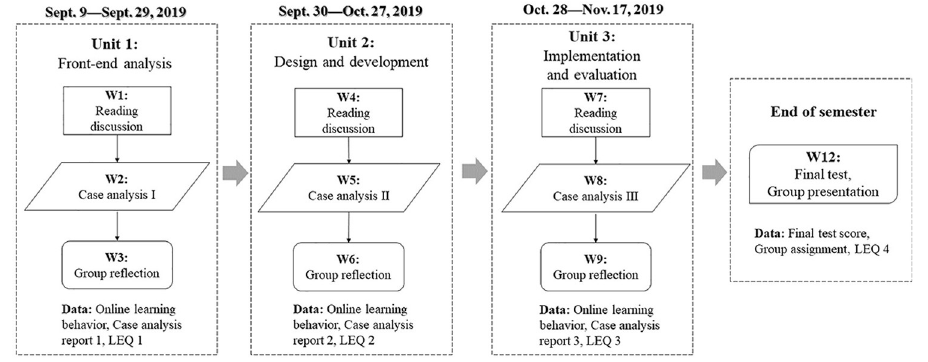
Fig 1. The blended learning activities and overall research